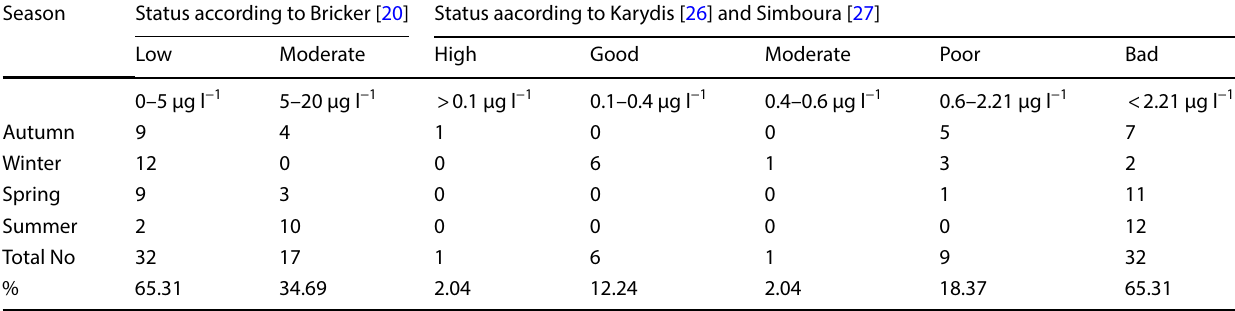
Table 2 Assessment of water quality in the harbor Season Status according to Bricker [20] Status aacording to Karydis [26] and Simboura [27] Low Moderate High Good